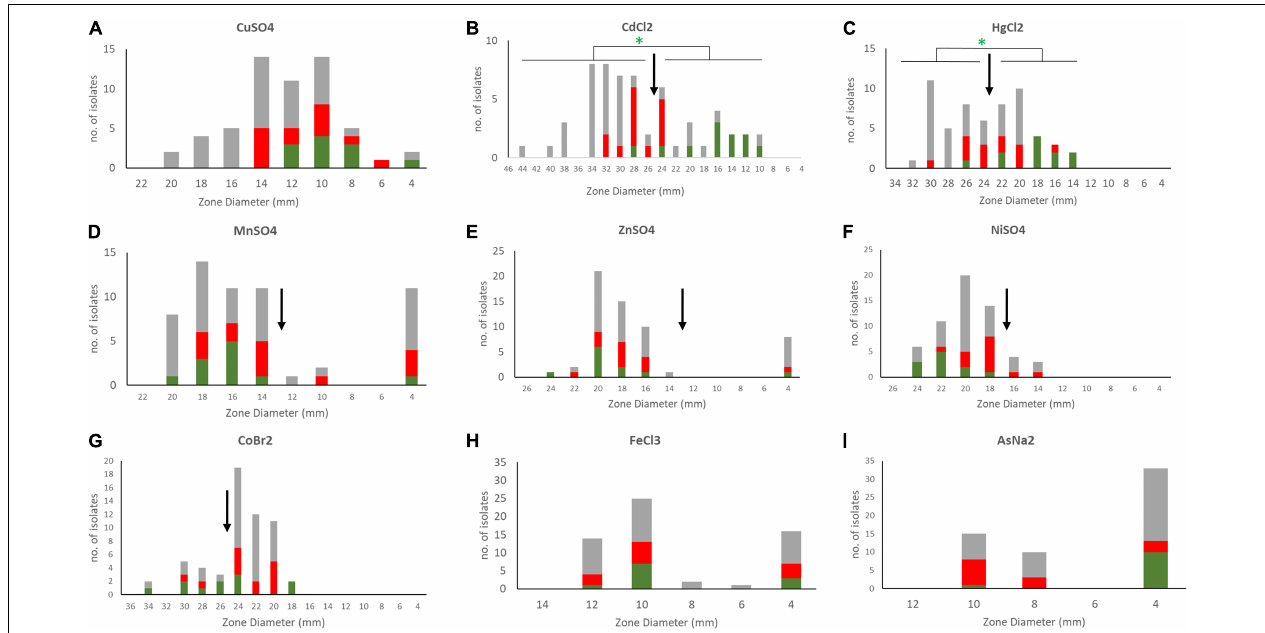
FIGURE 5 | Susceptibility profiles of S. epidermidis to different metals. Disc diffusion inhibition zones were defined for the 58 S. epidermidis isolates by exposing bacteria to discs containing 10 µ l of 1M metal stocks (0.2 M for mercury and arsenic) [ (A) copper, (B) cadmium, (C) mercury, (D) manganese, (E) zinc, (F) nickel, (G) cobalt, (H) iron, and (I) arsenic]. Metals tested included copper sulfate (CuSO 4 ), nickel sulfate (Niso 4 ), iron chloride (FeCl 3 ), manganese sulfate (MnSO 4 ), zinc sulfate (ZnSO 4 ), cobalt bromide (CoBr 2 ), cadmium chloride (CdCL 2 ), mercuric chloride (HgCl 2 ), and sodium arsenate (AsNA 2 ). In the bar charts ACME containing isolates are shown in red, COMER-like element containing isolates in green and all other isolates in gray. ECOFFs are shown in arrows. Statistical analysis of the association of isolates carrying COMER-like elements with cadmium and mercury susceptibility is shown (Fisher’s exact